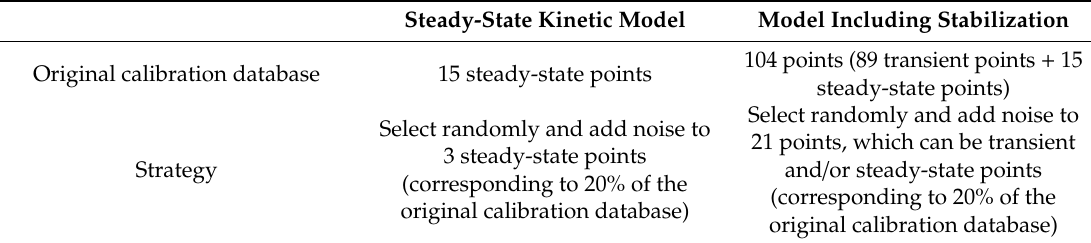
Table 3. Strategy of adding noise to the calibration